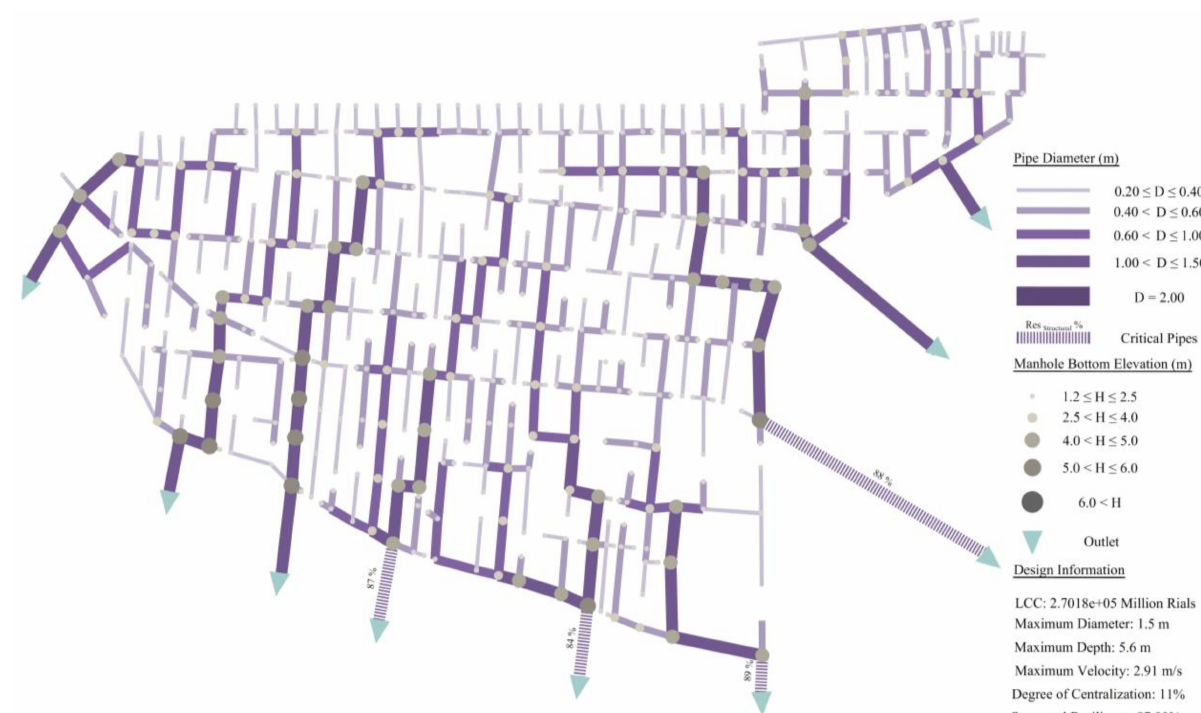
Figure 9. Design 3 (LCC = 270,180 M. Rials and DC =